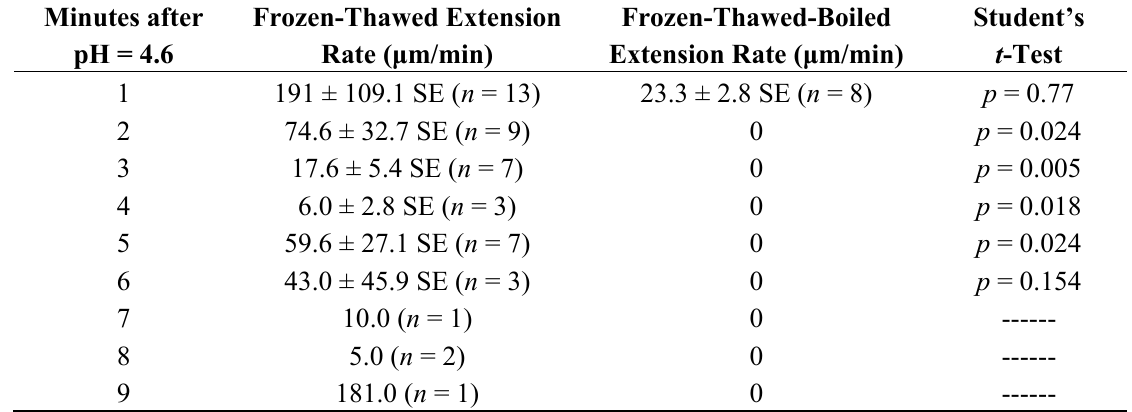
Table 2. Extension rate for each minute and the result of the Student’s t -tests for frozen-thawed and frozen-thawed-boiled cell